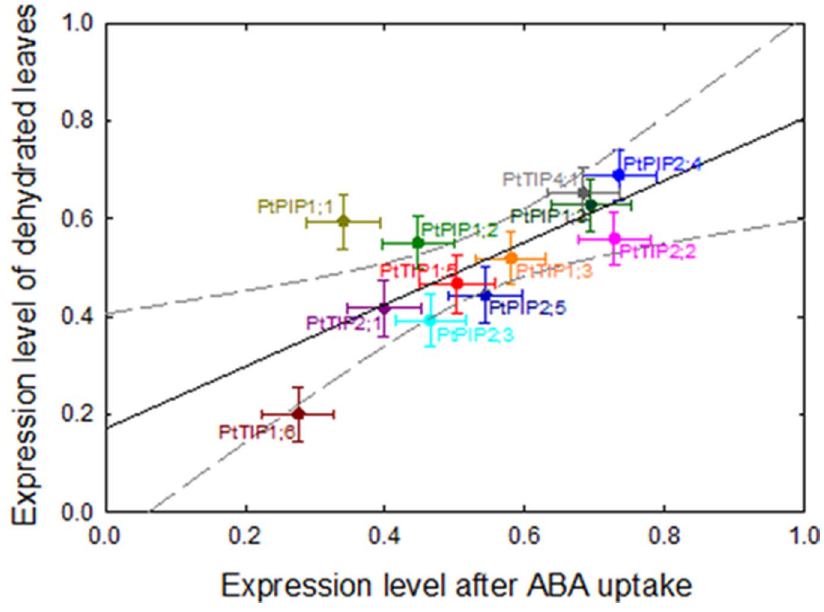
Figure 6. Relative expression of 12 aquaporin genes in response to dehydration (y-axis) and dehydration + perfusion with abscisic acid (x-axis). Detached leaves were either dehydrated on the bench top for 1 h or dehydrated for 1 h and subsequently perfused for 1 h with 50 m M abscisic solution (ABA). Data from fully hydrated detached leaves (perfused for 3 h with 20 mM KCl + 1 mM CaCl 2 solution) were used as the control group, and their expression refers to a value of 1. Pearson’s r=0.725; P # 0.01. Data are means 6 SE of three biological replicates.